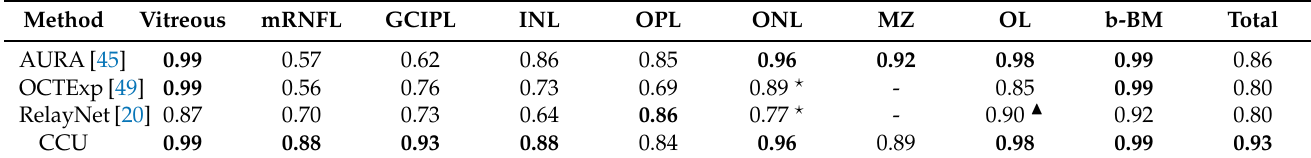
Table 9. DSCs are computed using 45 manually delineated B-scan images between AURA, OCTExp, RelayNet and CCU. (cid:63) RelayNet and OCTExp segment ONL + MZ in a single class; therefore, MZ column is empty for both, and ONL column shows DSC for both ONL and MZ. (cid:78) RelayNet segments OL in two different classes. For this comparison, we combined both classes in OL and computed DSC with respect to manual segmentation. The best outcomes for each layer are highlighted in bold.